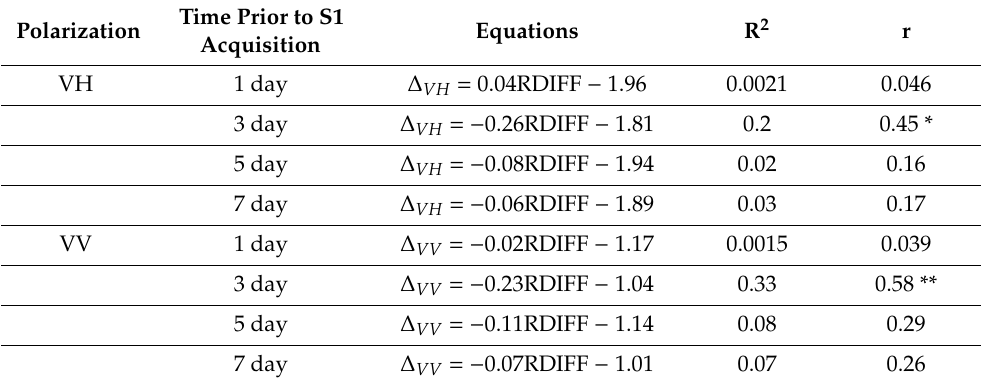
Table 1. Relationships between mean pre-fire to post-fire backscatter di ff erences ∆ VH and ∆ VV for the 30 KNP burn events and the total rainfall pre-fire S1 minus total rainfall post-fire S1 (RDIFF) where rainfall data are derived for one, three, five, and seven days before the pre-fire and before the post-fire Sentinel-1 acquisition dates. Rainfall data are extracted from the weather station data located closest to the burn